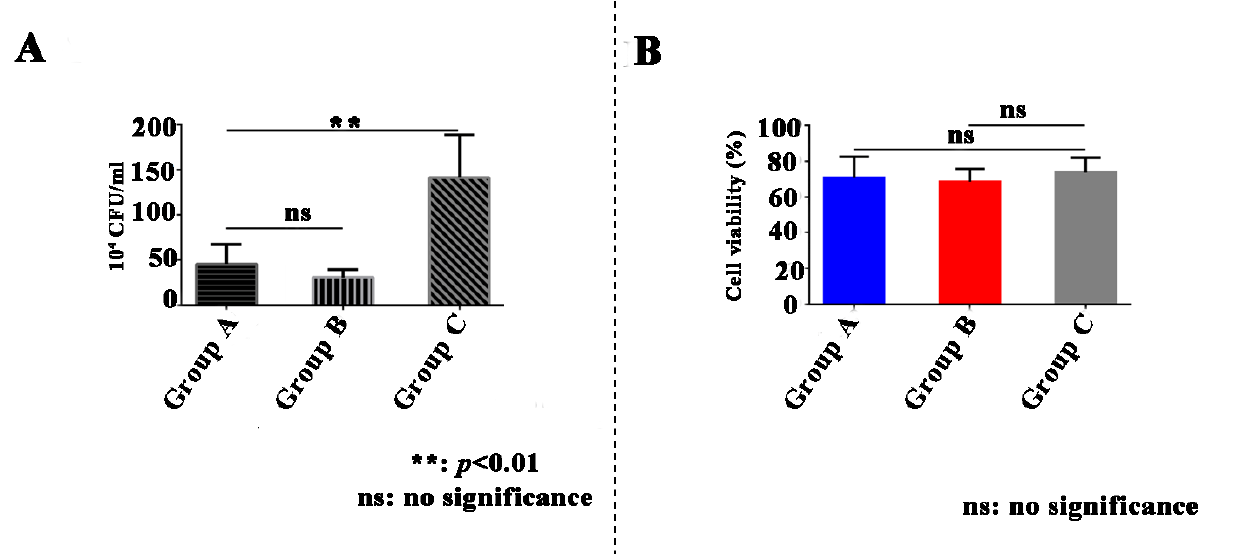
Figure 8. Antibacterial and cytocompatibility evaluation. ( A ) Colony-forming unit (CFU) evaluation of enamel and synthesized biofunctional materials with 0.2 wt% graphene oxide (GO; Group A), with 0.4 wt% GO (Group B), and without the addition of GO (Group C) after incubation for 24 h. ( B ) Quantity of cells proliferated on synthesized biofunctional materials with 0.2 wt% GO (Group A), with 0.4 wt% GO (Group B), and without the addition of GO (Group C) after cell culture for seven days.